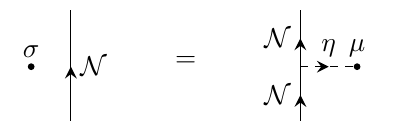
Figure 2. The non-invertible duality line N in the critical Ising CFT maps the spin operator (cid:27) to the disorder operator (cid:22) which lives at the edge of the Z 2 symmetry line (cid:17) .